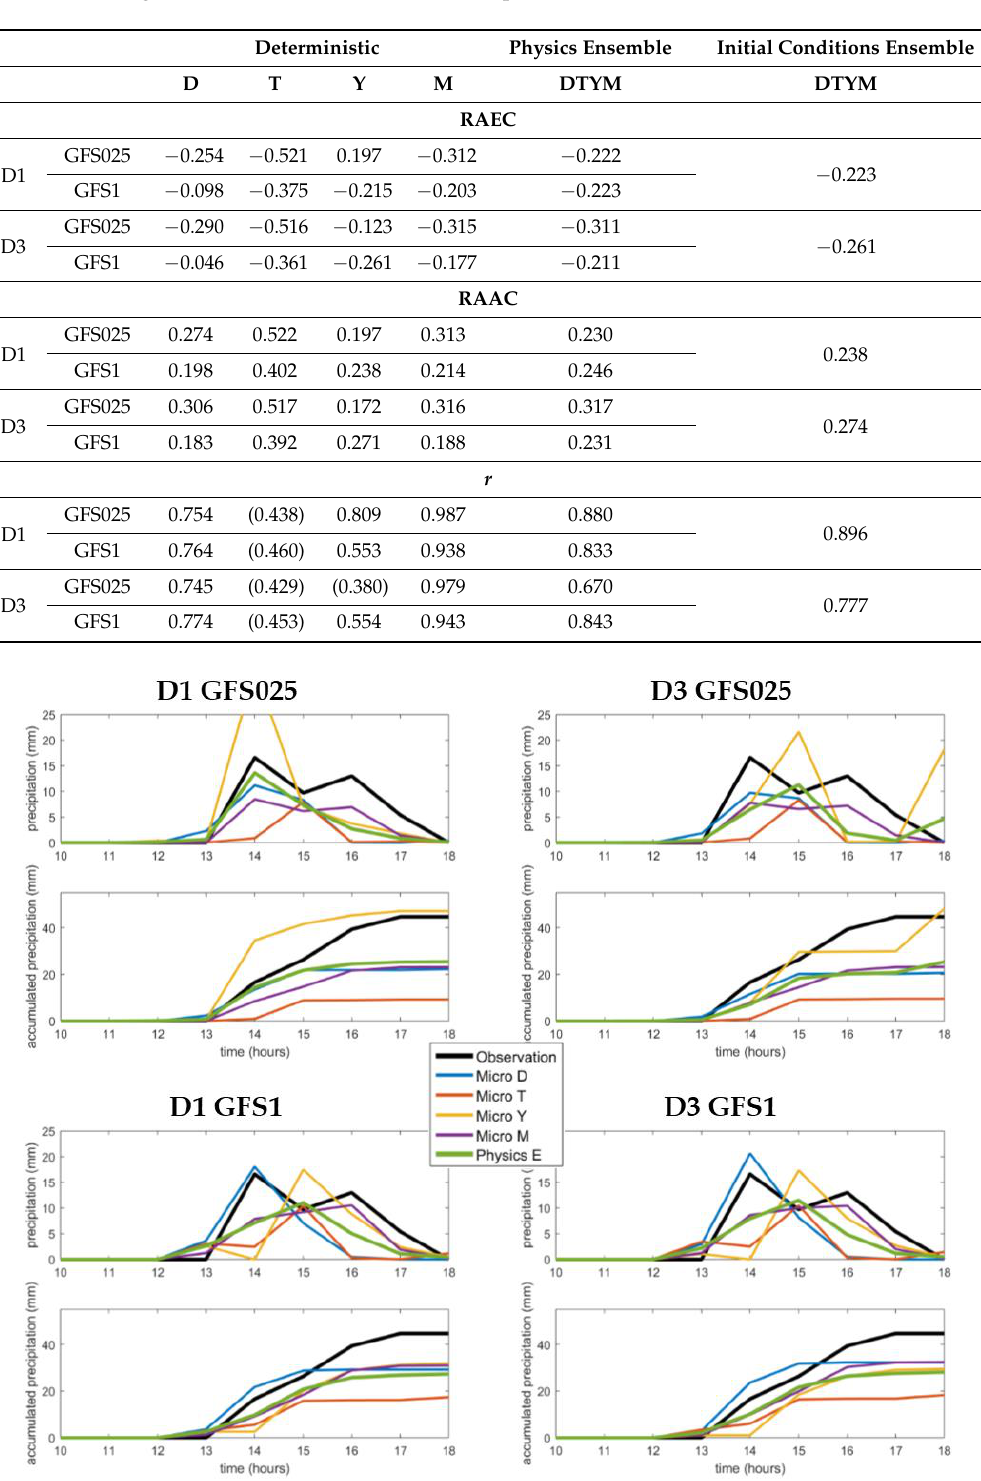
Table 7. LEMD station validation: RAAC, RAEC, and r values for a specific station. Only deterministic configurations, physics ensembles, and initial condition ensembles are shown. Values of r in parentheses denote a non-significant statistical result. Best three performers for each index are shaded.